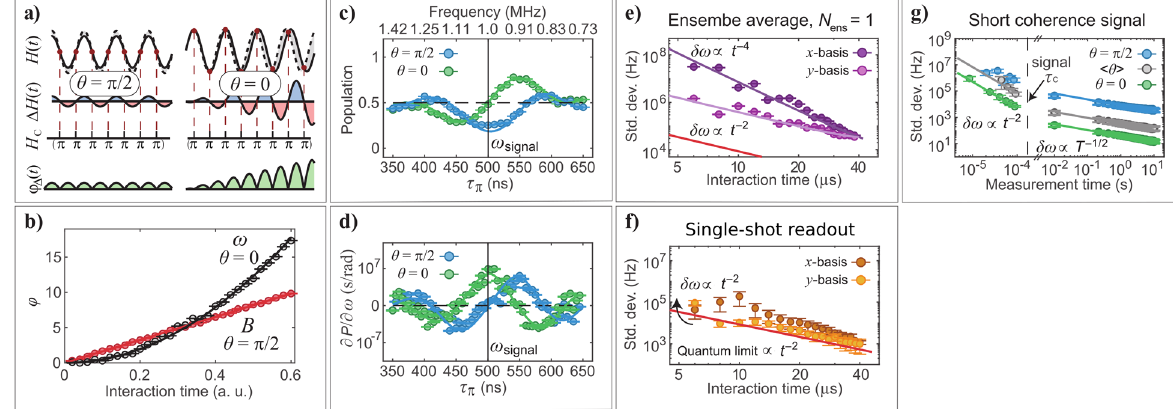
Fig. 6 Optimal quantum-frequency estimation. a Maximal sensitivity to amplitude changes is obtained for π -pulses at the signal nodes (cid:6) (cid:7) θ ¼ π , resulting in a linear accumulation of φ . Maximal sensitivity to frequency changes is obtained for π -pulses at the signal antinodes ( θ = 2 0). b Experimental data of the phase difference for a 1 µT change in amplitude (red) and 10 kHz change in frequency (black). Frequency estimation results in a quadratic increase of φ , whereas amplitude estimation produces a linear increase. c Measured NV population as a (blue) and θ = 0 (green). Fits correspond to Supplementary Eq. 39. d Measured derivative of the NV function of π -pulse spacing τ π , given θ ¼ π 2 (blue) and θ = 0 (green). Fits correspond to Supplementary Eq. 41. e Measured population as a function of π -pulse spacing τ π , given θ ¼ π 2 frequency uncertainty as a function of interaction time, for X (dark purple) or Y (light purple) measurement basis. Red line corresponds to Eq. (8) and pink line to Eq. (9). f Measured frequency uncertainty as a function of interaction time, for X (dark orange) or Y (light orange) measurement basis using a single SSR measurement. Red line corresponds to Eq. (8). g Frequency estimation for short coherence signals (for (blue), θ = 0 (green), and unknown initial phase (gray) for a single ensemble averaging): measured frequency uncertainty given θ ¼ π 2 measurement with interaction time shorter than the signal coherence time (200 µs). For longer times, the sensitivity is obtained from averaging multiple measurements, each with an interaction time of 97